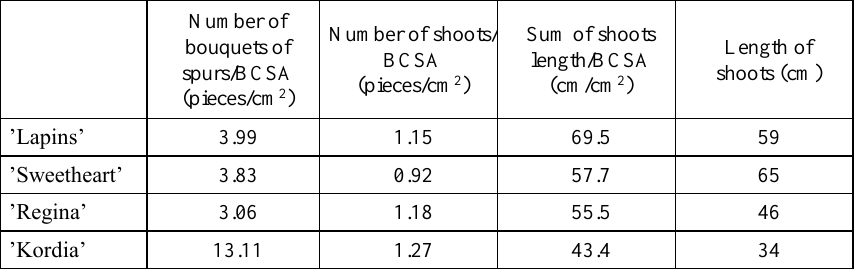
Table 6 . Fruit bearing parts of the basal scaffold branches (Debrecen – Pallag, 2017)